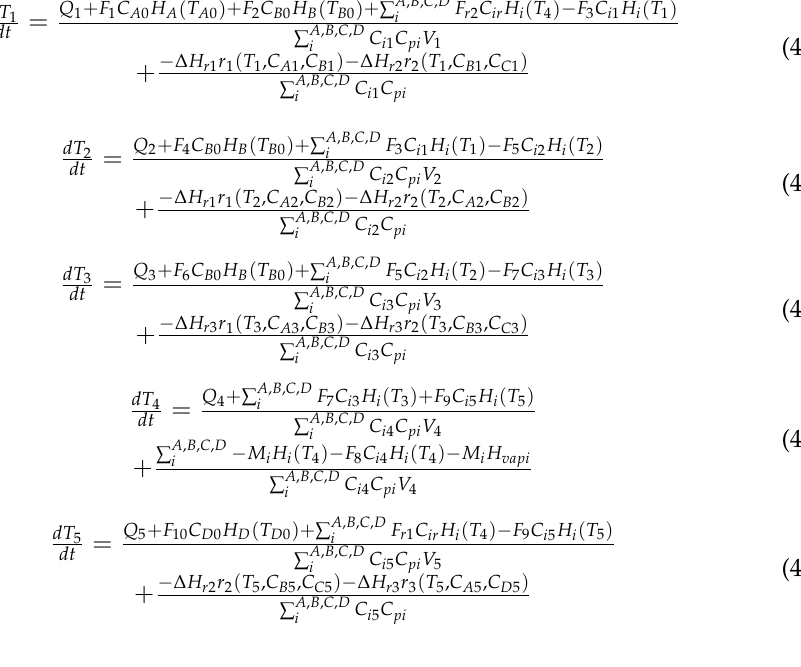
Figure 2. The proposed approach flowchart.